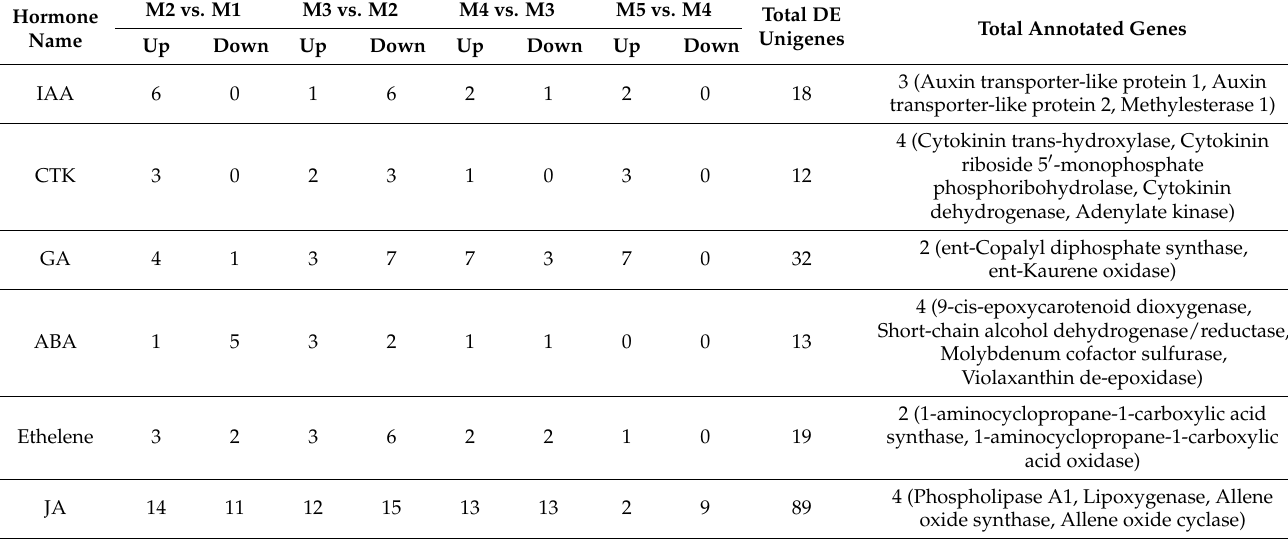
Table 1. Differentially expressed D. pectinatum unigenes involved in hormone metabolism among male cone samples. Hormone